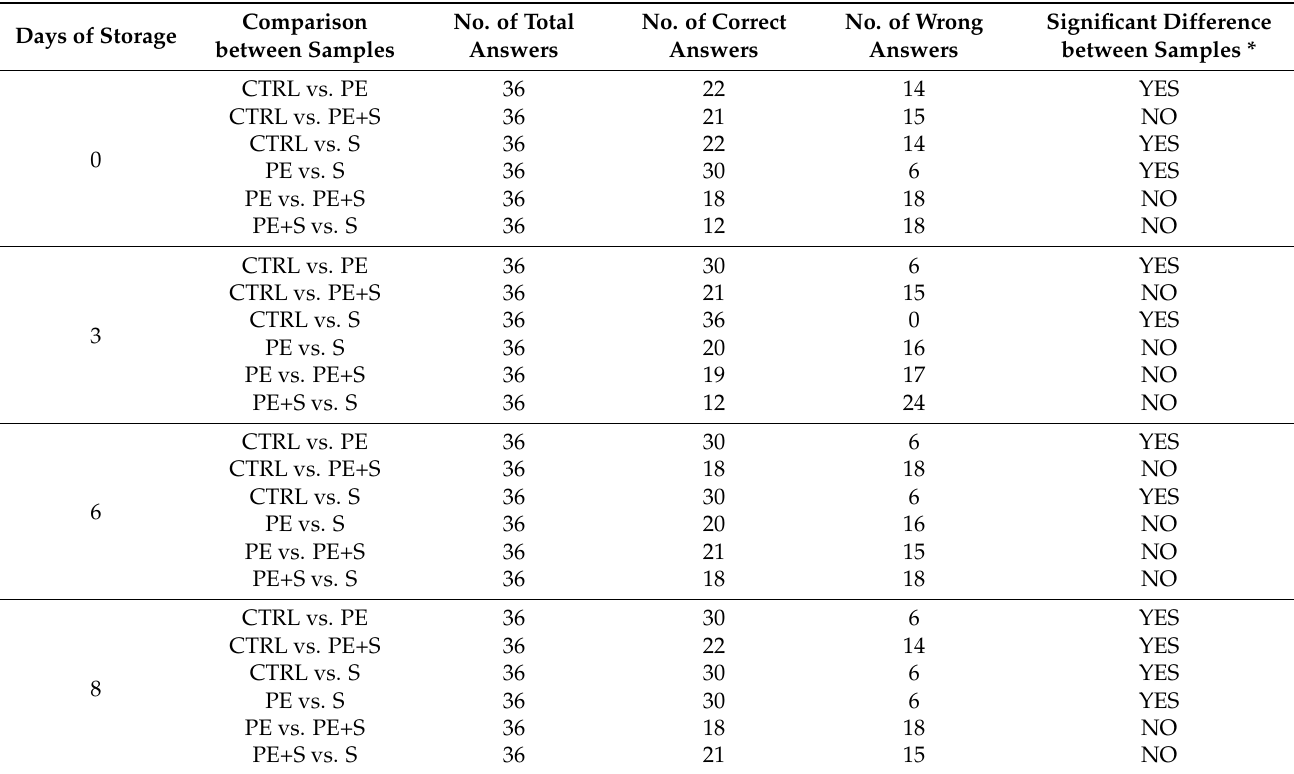
Table 3. Results of the sensory discriminant triangle test assessed in control (CTRL), sulphites (S), phenolic extract (PE), and phenolic extract + sulphites (PE+S) shrimps at days 0, 3, 6, and 8 of storage. Comparison No. of Total No. of Correct No. of Wrong Days of Storage between Samples Answers